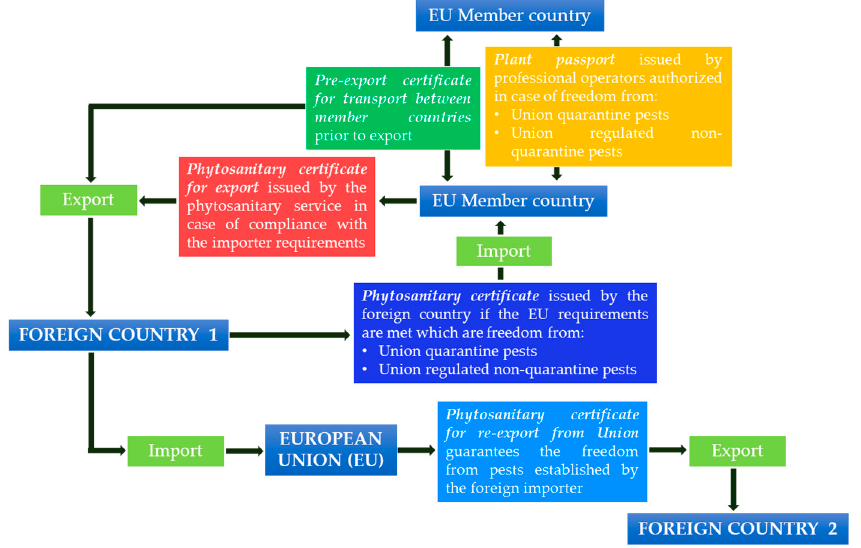
Figure 1. Flowchart representing the steps for the movement of plant propagation materials inside and outside the European community, with reference to the certificates and phytosanitary requirements according to the Community Regulation on Plant Health 2016/2031 [53].